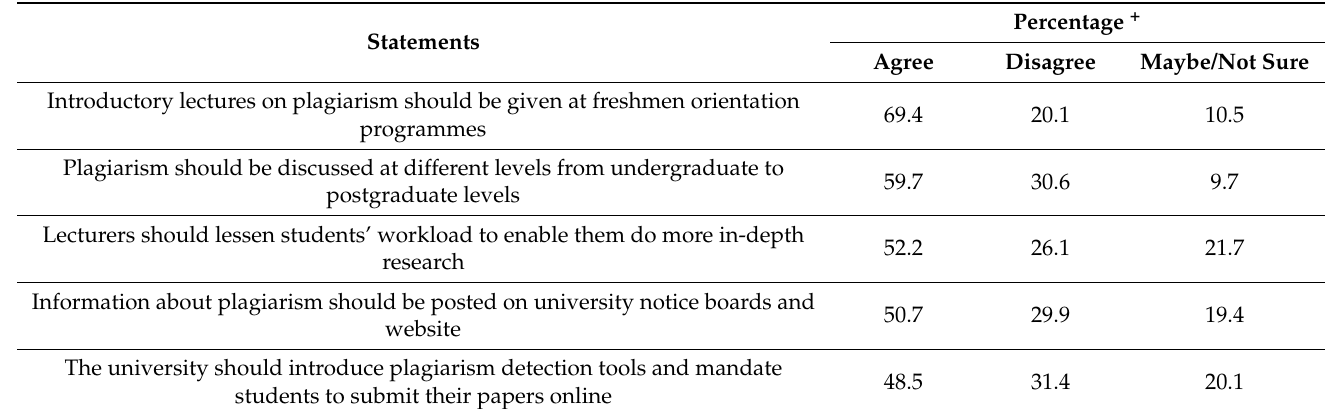
Table 3. Strategies to combat